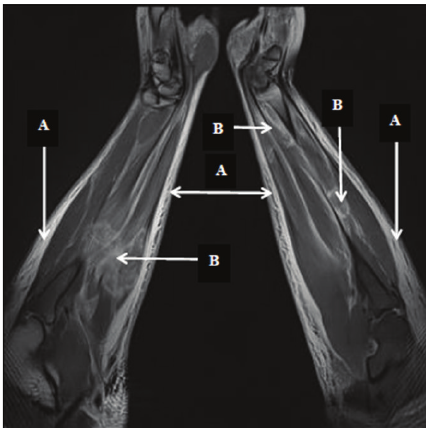
Figure 3: Coronal fat-suppressed proton density-weighted MR images of both forearms show diffuse hyperintensity in the subcuta- neous fat tissue (A) and multifocal, confluent areas of hyperintensity in the muscles due to edema